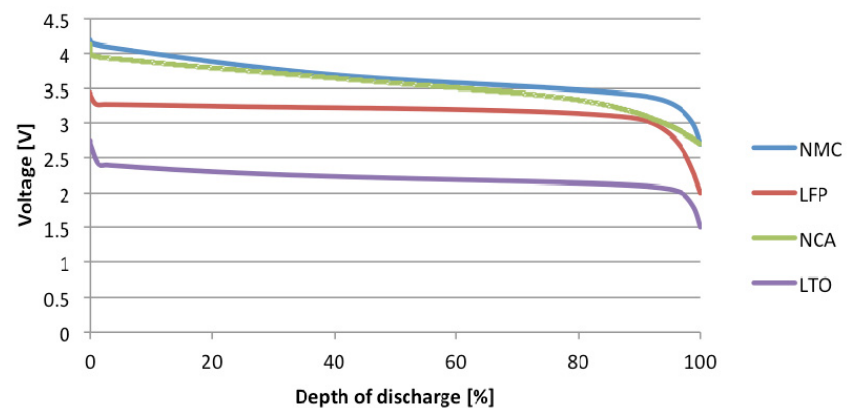
Figure 2. Voltage duration of various lithium-ion